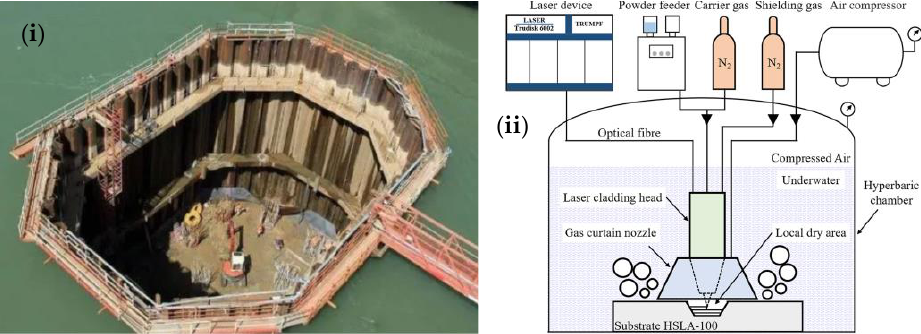
Figure 5. Options for dry welding underwater. ( i ) Cofferdam [6], ( ii ) hyperbaric chamber [7] (permission granted by Elsevier).